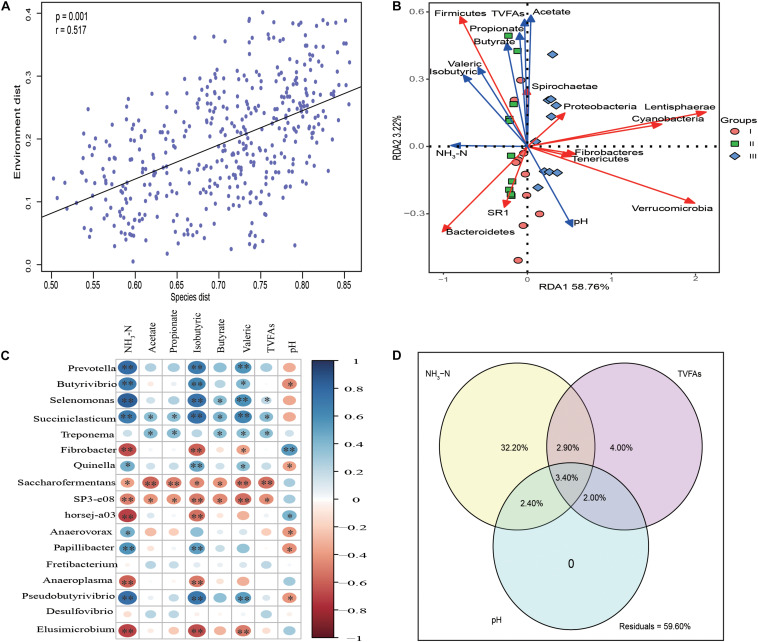
Statistic analysis of the relationship between rumen bacteria community and fermentation parameters. (A) Mantel test analysis between bacteria communities (OTU level) and rumen fermentation parameters. (B) Redundancy analysis (RDA) of the top 10 phyla in association with rumen fermentation parameters. (C) The correlation heatmap using spearman analysis between the top 17 rumen bacteria communities and rumen fermentation parameters. (D) Variation partition analysis (VPA) of different factors to the variation of bacteria community structure in rumen samples. The relative abundance of top 17 genera whose relative abundance >0.5% in at least one group are used for spearman analysis and the relative abundance of the genera are used as input for VPA analysis.